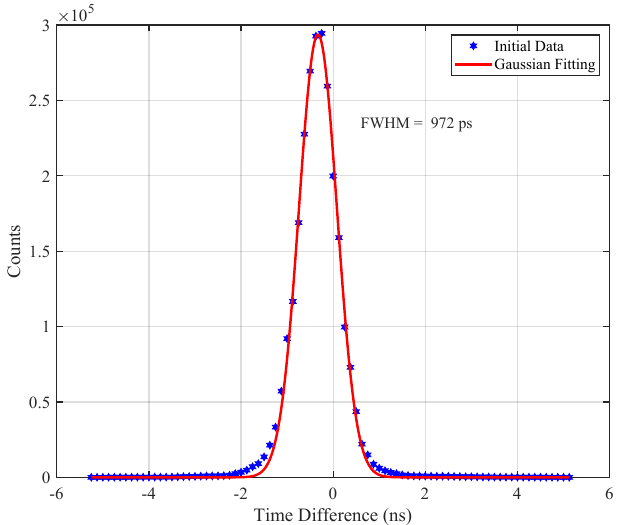
Figure 18. The timing spectrum obtained with a pair of detectors. The coincidence timing resolution of 972 ps obtained by fitting with a Gaussian